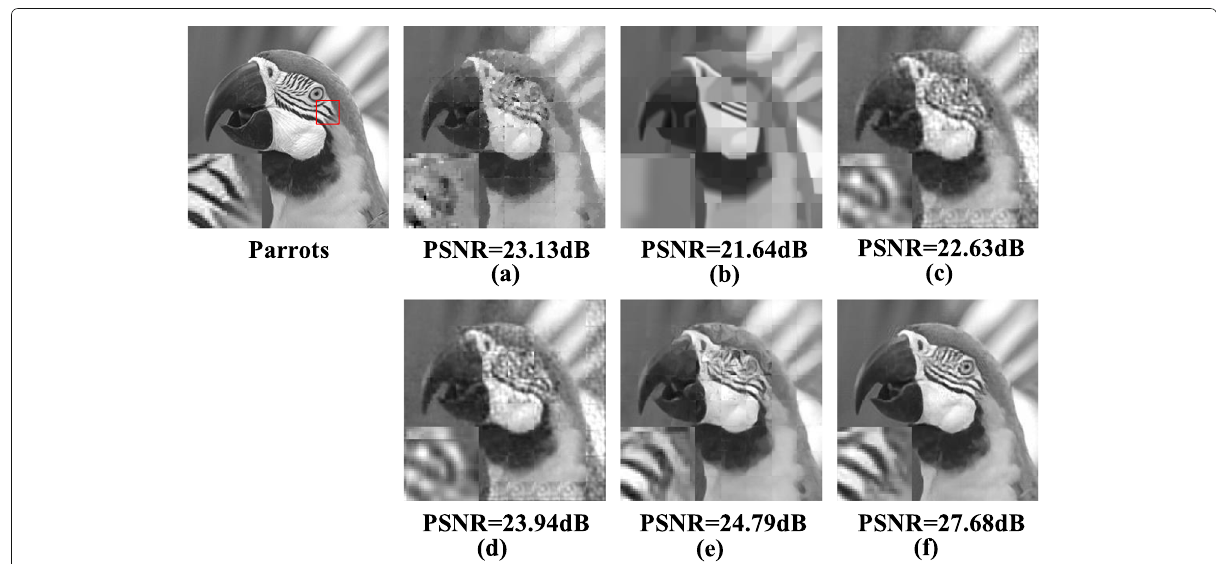
Fig. 5 The reconstruction results of Parrots at the measurement rate of 0.1 without BM3D. a TVAL3. b DAMP. c ReconNet. d DR 2 -Net. e CSRNet. f ASRNet